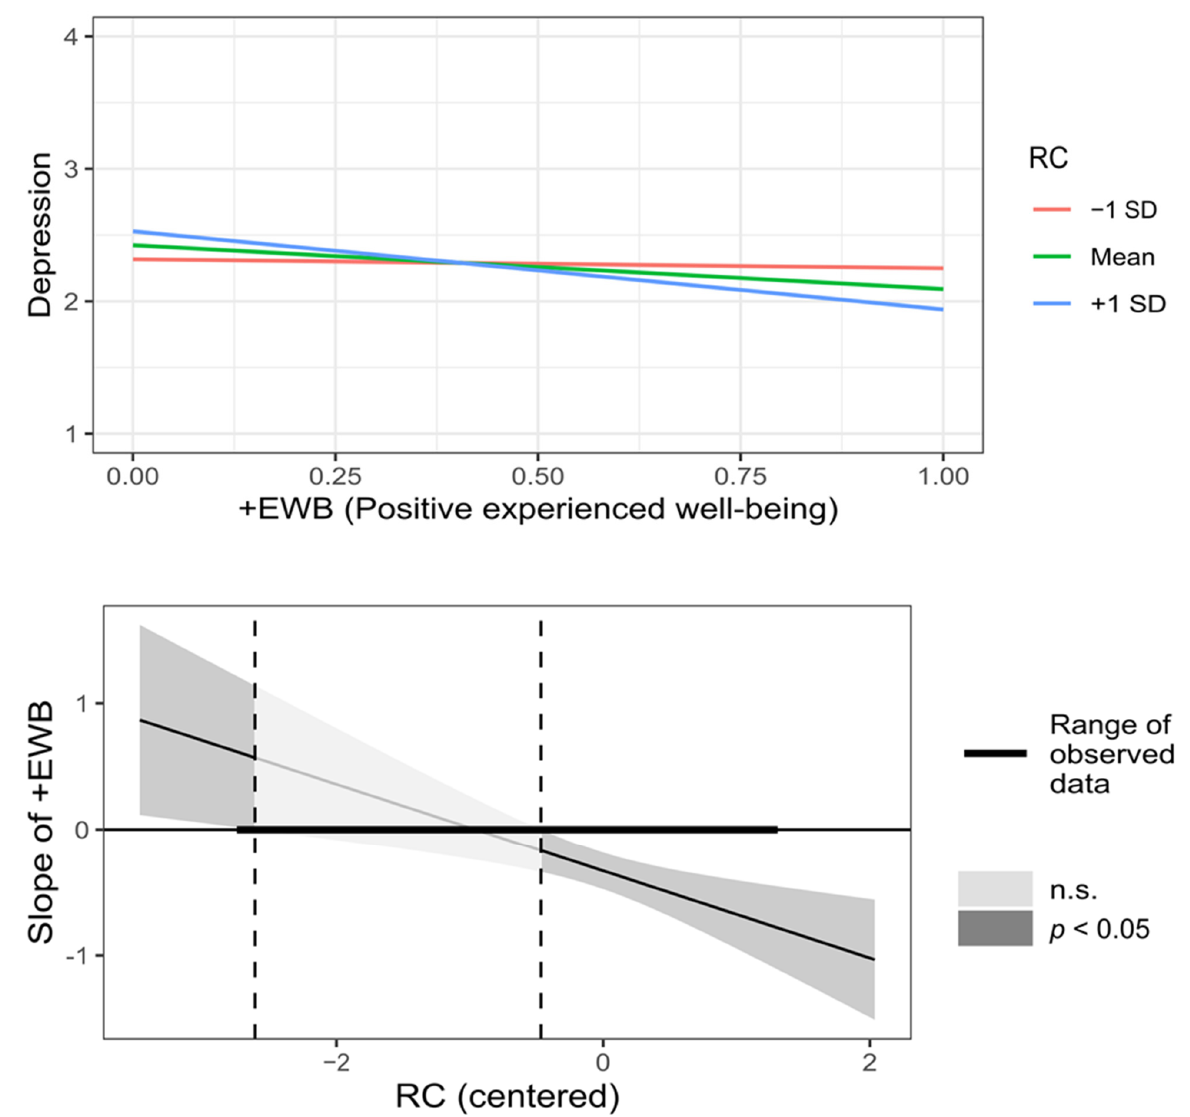
hypotheses H7.2, H7.3, H8.1, and H8.3 were not supported.